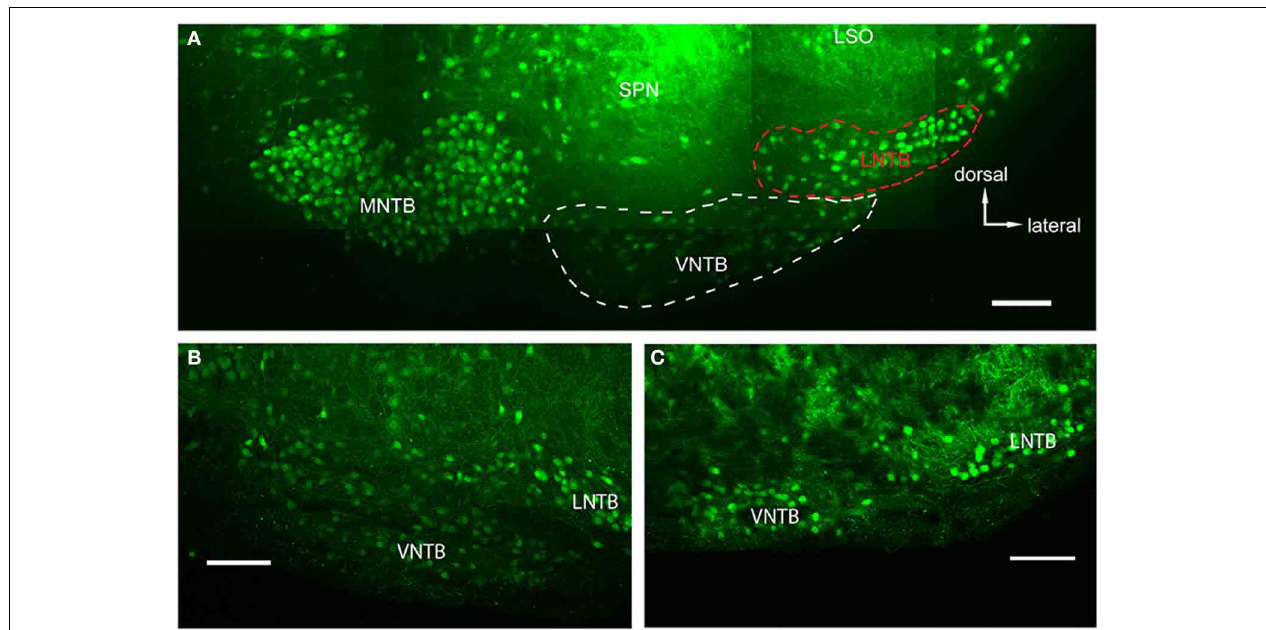
FIGURE 2 | Glycinergic auditory nuclei in a brainstem of a p14 GlyT2-GFP mouse. (A) Maximum projection of 10 tiled confocal stacks through a 200 µ m brain section cleared prior to imaging using the Clear T2 -protocol. Five major nuclei with glycine label can be seen: the medial nucleus of the trapezoid body (MNTB), the ventral and lateral nuclei of the trapezoid body (VNTB and LNTB, outlined with white and red dashed lines,